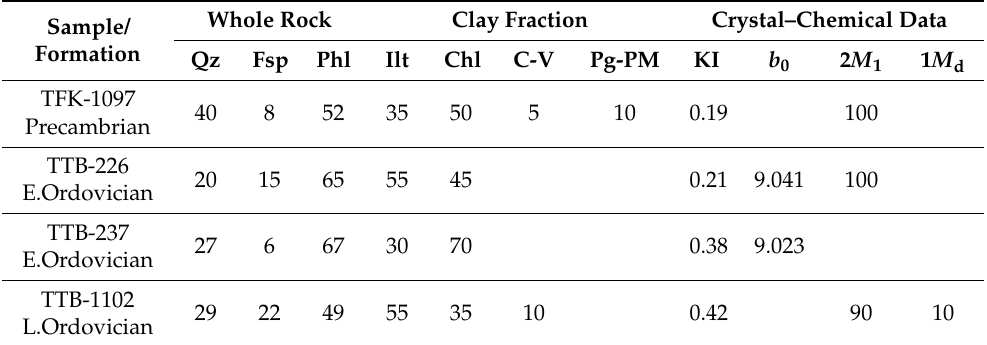
(TTB-237) and low-anchizone (TTB-1102) grades (Table 2). b 0 (Å) values of illites/micas indicate the moderate to high pressure facies series [49,50]. The dominance of 2 M 1 polytype illite/mica contents corresponds to anchizonal-epizonal grades [6,7]. The phyllosilicate associations and crystal–chemical data exhibit reasonable compatibility for